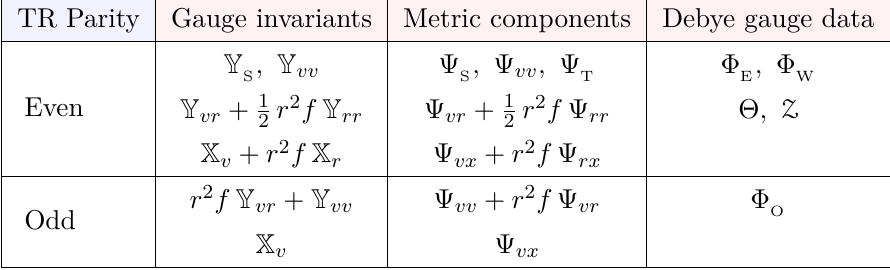
Table 2 . Time-reversal parity of the scalar perturbation of Schwarzschild-AdS d +1